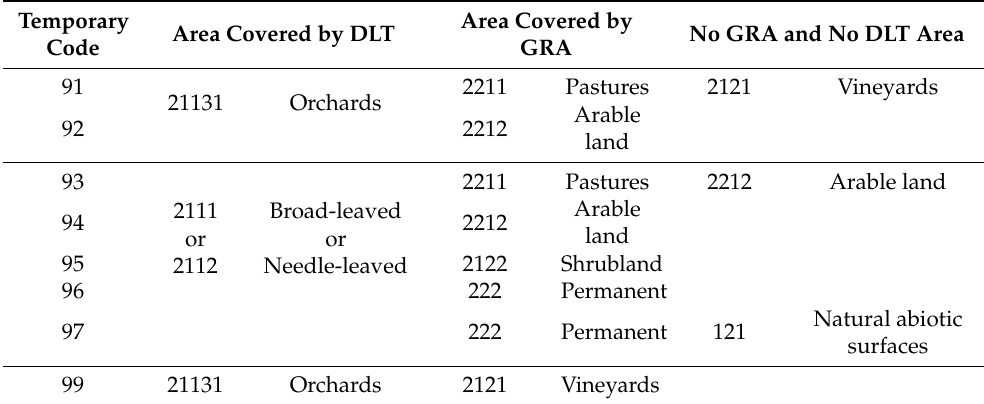
Table 5. Attribution of classes to temporary codes using HRL. DLT = dominant leaf type, GRA =